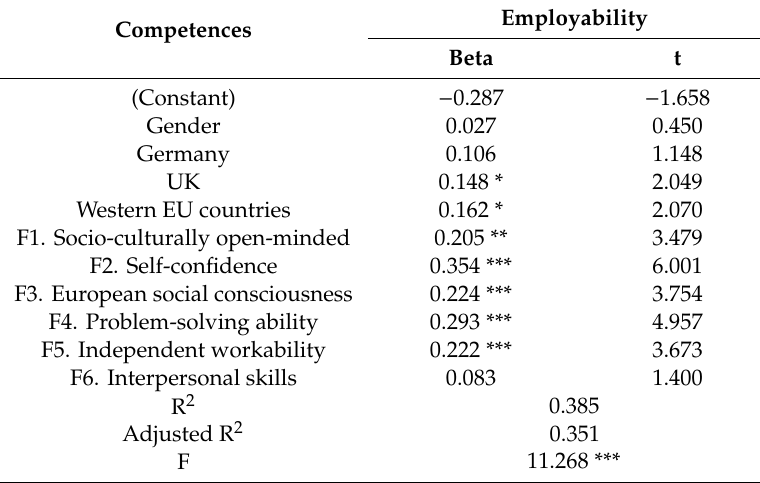
Table 7. Regression model: employability